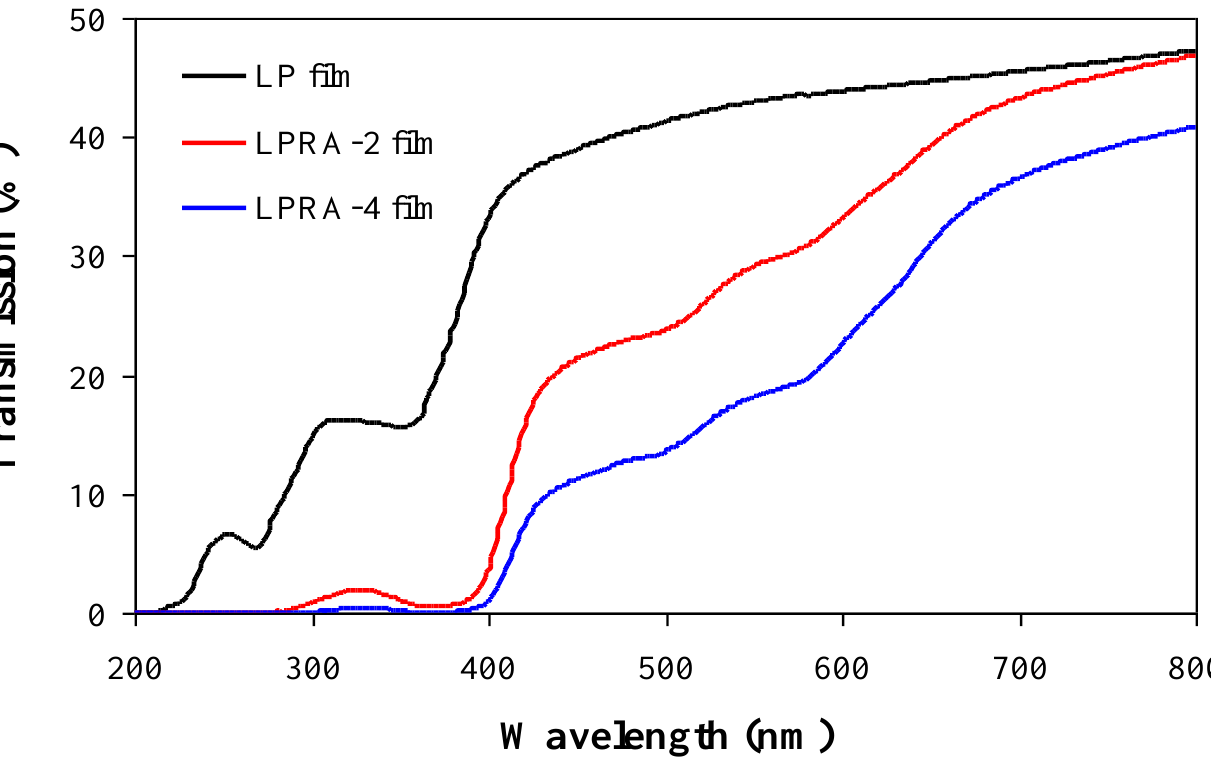
Figure 3. Light transmittance of LP film, LPRA-2 film, and LPRA-4 film. 3.6.